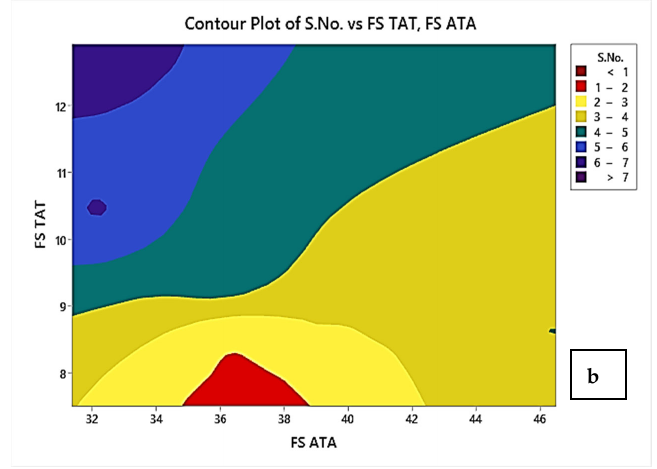
Figure 9. Two ‐ dimensional contour plots for ( a ) break elongation and ( b ) flexural strength of ATA and TAT samples.